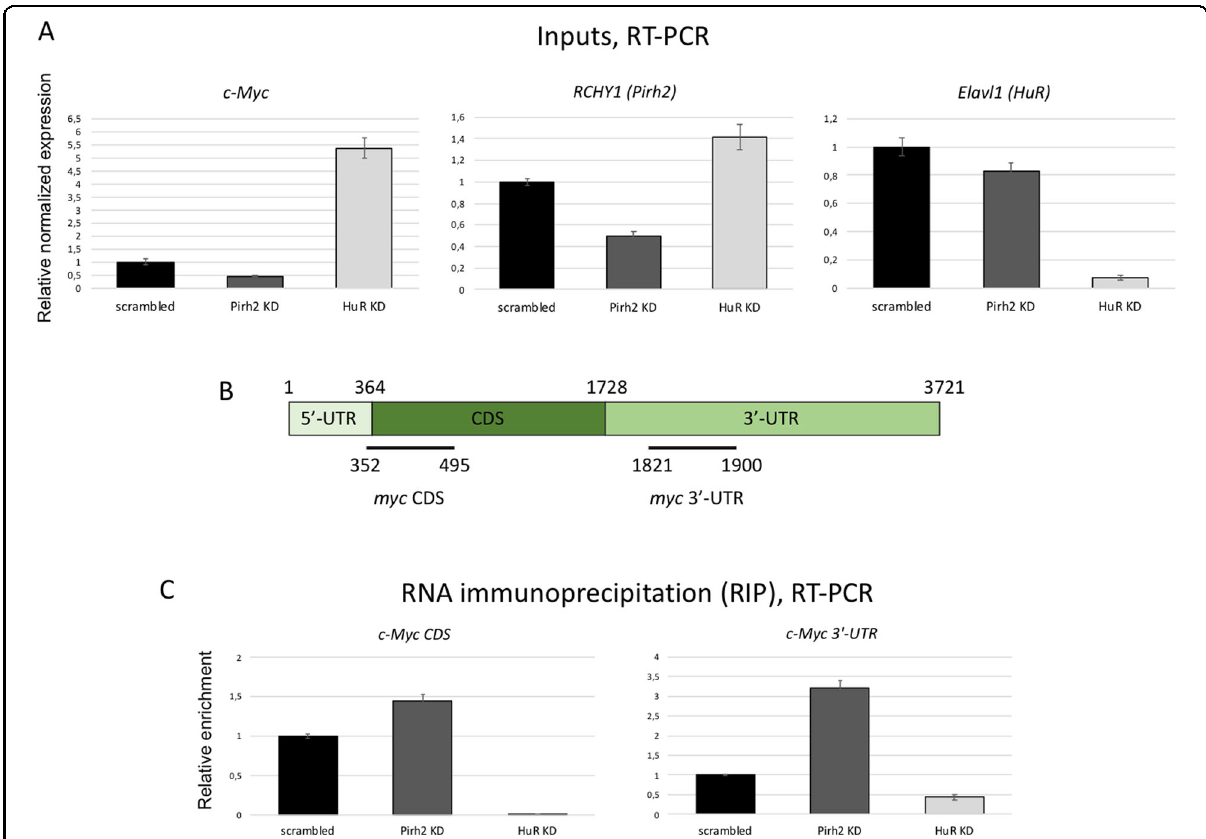
Fig. 6 Pirh2 prevents HuR binding to c-Myc mRNA. A qRT-PCR demonstrating the expression of c-Myc, HuR, and Pirh2 mRNA in Pirh2 knockdown (Pirh2 KD), HuR knockdown (HuR KD), and control (scrambled) H1299 cells used for RNA immunoprecipitation (RIP assay). B The scheme of c-Myc- coding mRNA (NCBI Reference Sequence: NM_002467.6) with indicated regions covered by primes used for RIP assay. CDS, coding sequence; UTR, untranslated regions. C RNA immunoprecipitation results obtained by